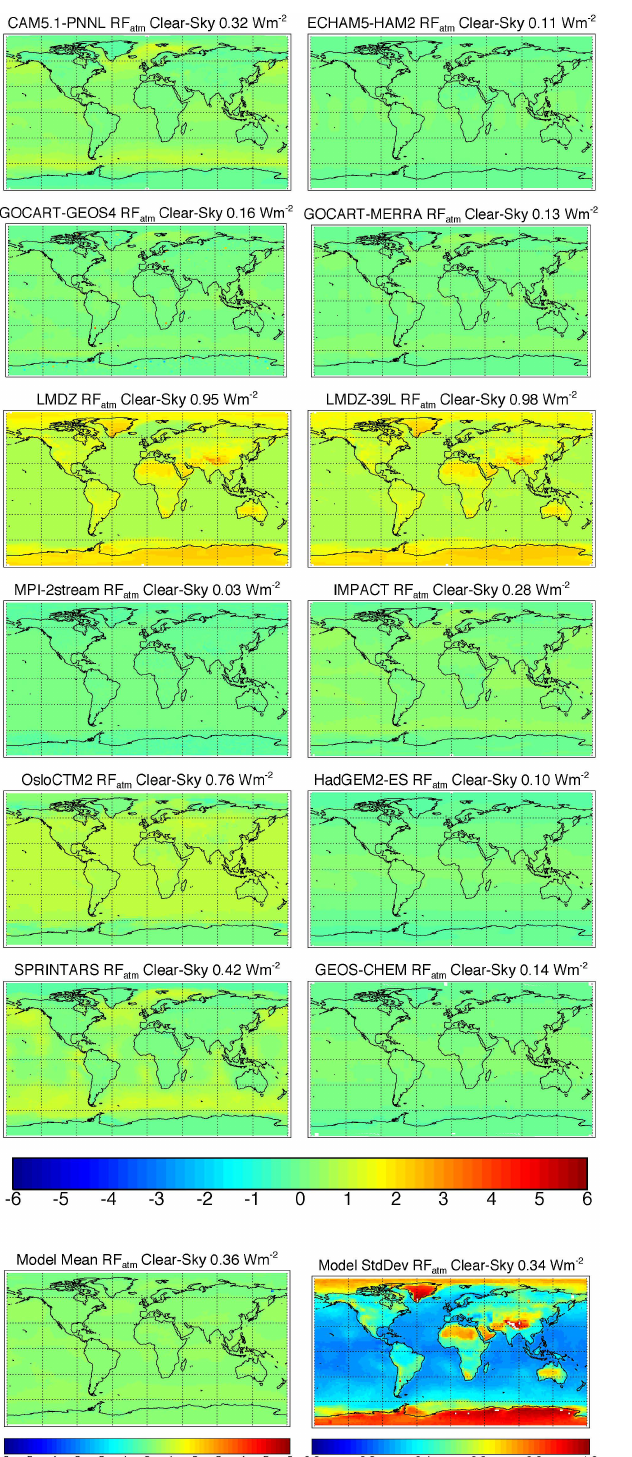
Fig. 7. Annual mean short-wave clear-sky atmospheric radiative forcing (absorption) between experiments with AOD=0.2 and AOD=0.0 distributed over the lowest two kilometers, holding SSA=1.0 and ANG=1.0 constant (FIX2-FIX0).